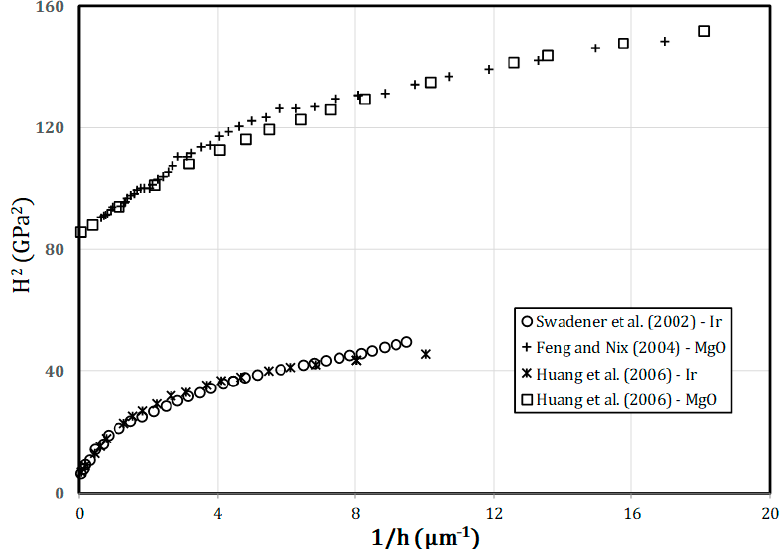
Figure 7. Comparison between the indentation size effect captured using the strain gradient plasticity model developed by Huang et al. [99] using a cap for GND density versus the experimental results in = 9.68 × 10 (cid:2869)(cid:2872) m (cid:2879)(cid:2870) , (cid:2025) (cid:3008)(cid:2923)(cid:2911)(cid:2934) = 1.28 × 10 (cid:2869)(cid:2874) m (cid:2879)(cid:2870) (cid:4673) . The original simulation and Ir and MgO (cid:4672)(cid:2025) (cid:3008)(cid:2923)(cid:2911)(cid:2934) (cid:2893)(cid:2928) (cid:2897)(cid:2917)(cid:2899) experimental data have been reported by Swadener [14], Feng and Nix [98] and Huang et al.